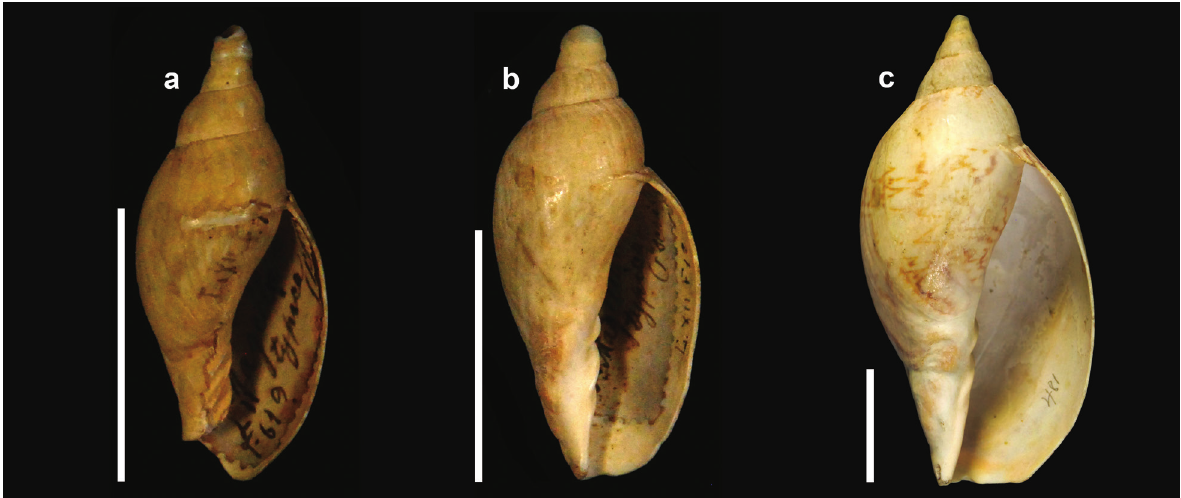
Figure 2. Voluta ambigua typica , specimens figured by Lahille (1895). See references on Table 1. Scale bars: 3